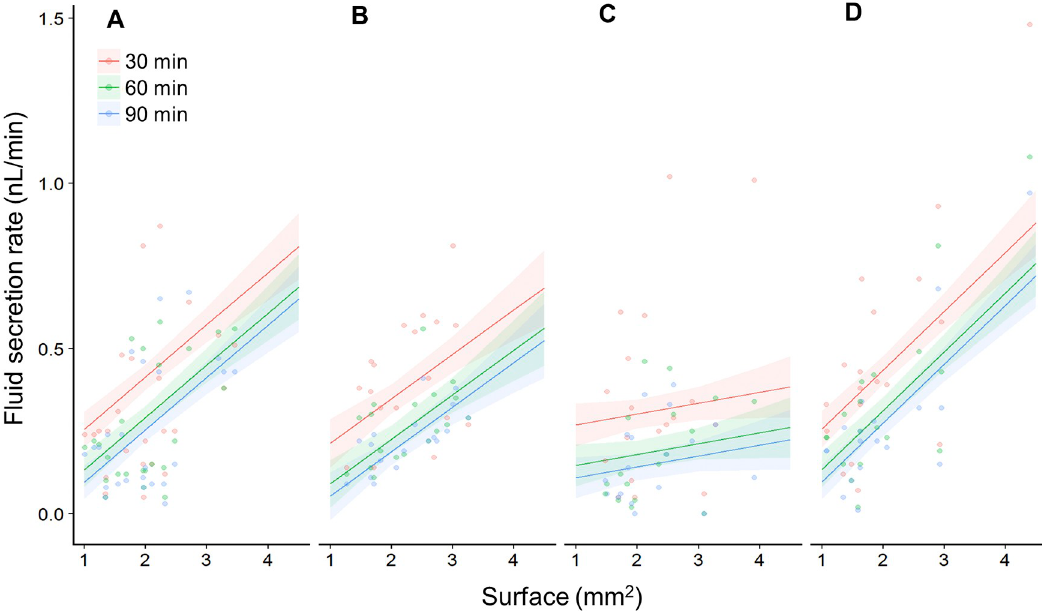
Fig 2. Tubule surface area positively influences the fluid secretion rate. ( A ) A plot of the surface area of the tubule exposed to the bath versus the fluid secretion rate for the R60 treatment every 30 minutes. ( B ) As in ‘A’ but for the V125 treatment. ( C ) As in ‘A’ but for V250 treatment. ( D ) As in ‘A’ but for the saline treatment. Small circles indicate the fluid secretion rates of individual tubules at a particular time point. Each line with the shaded area around represents the mixed effect model fit with the standard error.